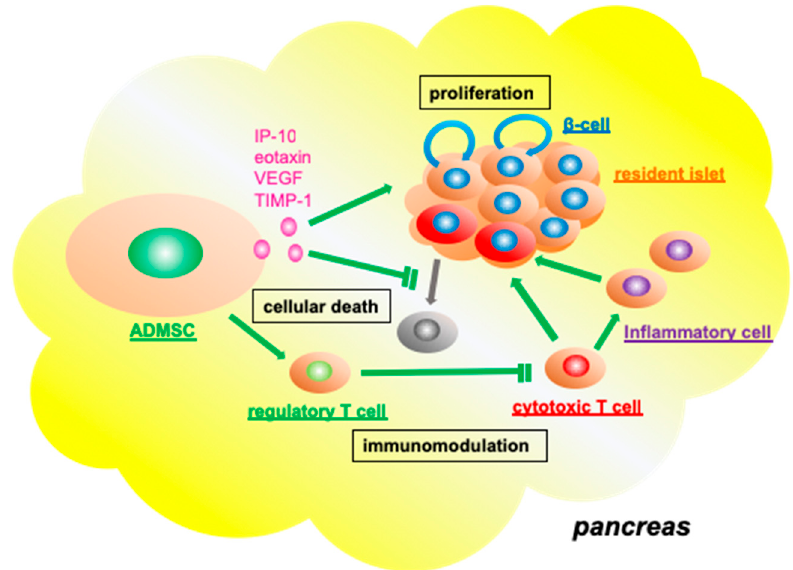
Figure 3. Functional role of adipose tissue-derived mesenchymal stromal cells in the resident pancreatic islets. Transplanted adipose tissue-derived mesenchymal stromal cells (ADMSCs) release functional molecules, including interferon gamma-induced protein-10 (IP-10), eotaxin, vascular endothelial growth factor (VEGF), and tissue inhibitor of metalloproteinase-1 (TIMP-1) to promote the viability and proliferative capacity of endogenous β -cells. ADMSCs also upregulate regulatory T cells and downregulate cytotoxic T cells, which inhibit inflammatory cell infiltration (immunomodulation).